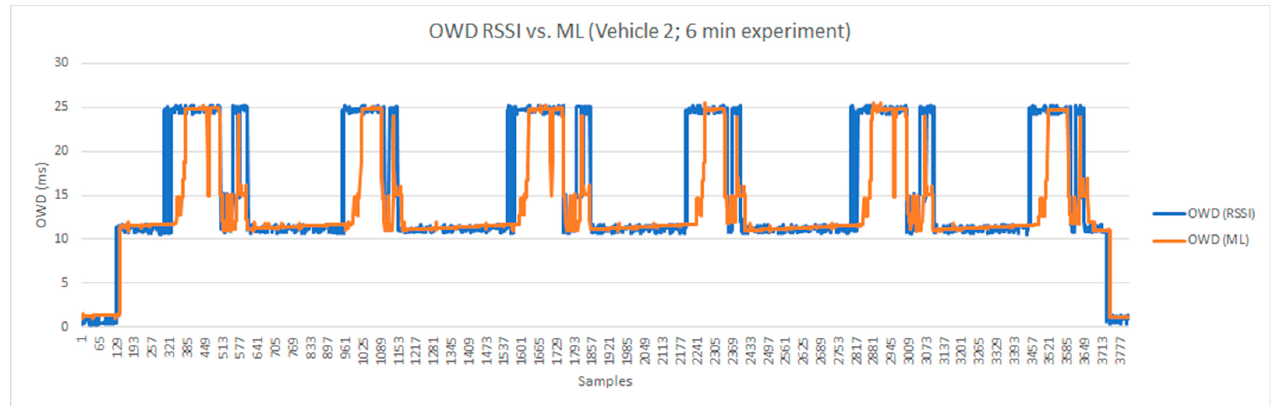
Figure 14. OWD of vehicle 2 in the short emulation experiment (6 min), where decision making was facilitated with a ML-based model. A simple heuristic (RSSI-based) model was used as a reference case.